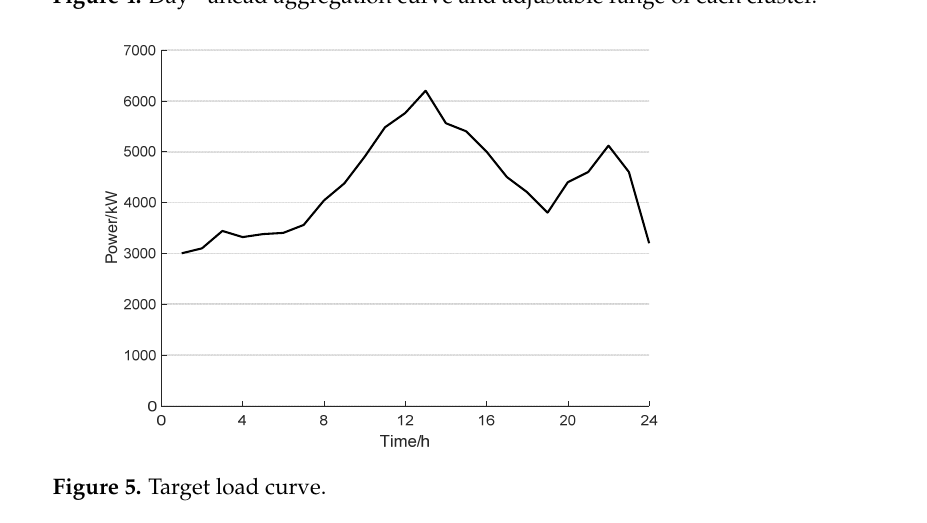
Figure 4. Day − ahead aggregation curve and adjustable range of each cluster.